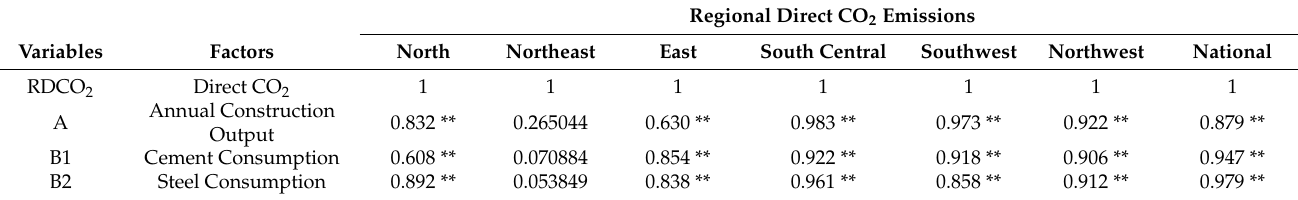
Table 7. EcoF–RDCO2 direct CO 2 emissions in China’s construction sector correlation analysis report. Regional Direct CO 2 Emissions North Northeast